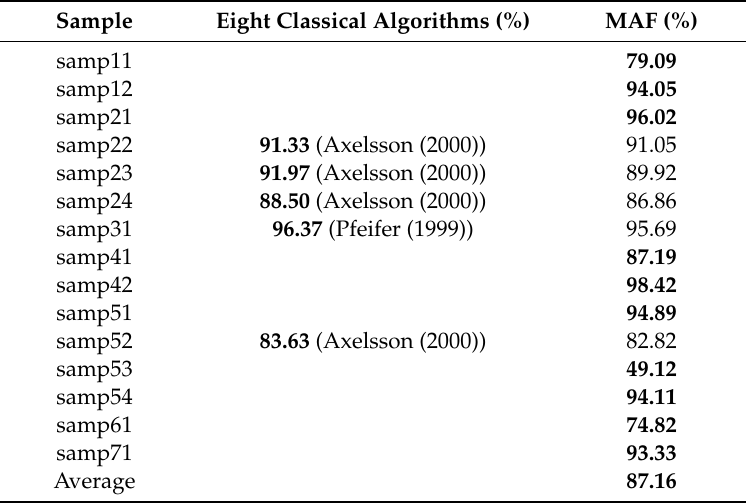
Table 3. Comparison of MAF kappa coe ffi cients and the eight classic algorithms for all the ISPRS samples (the bold value is the largest value in each line, and indicates that the corresponding method had the best performance for the study